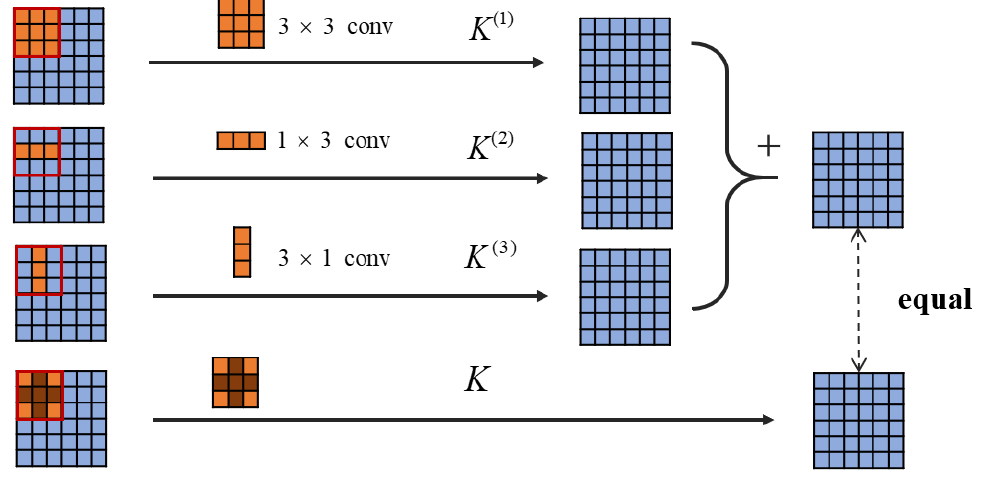
Figure 7. Schematic illustration of the